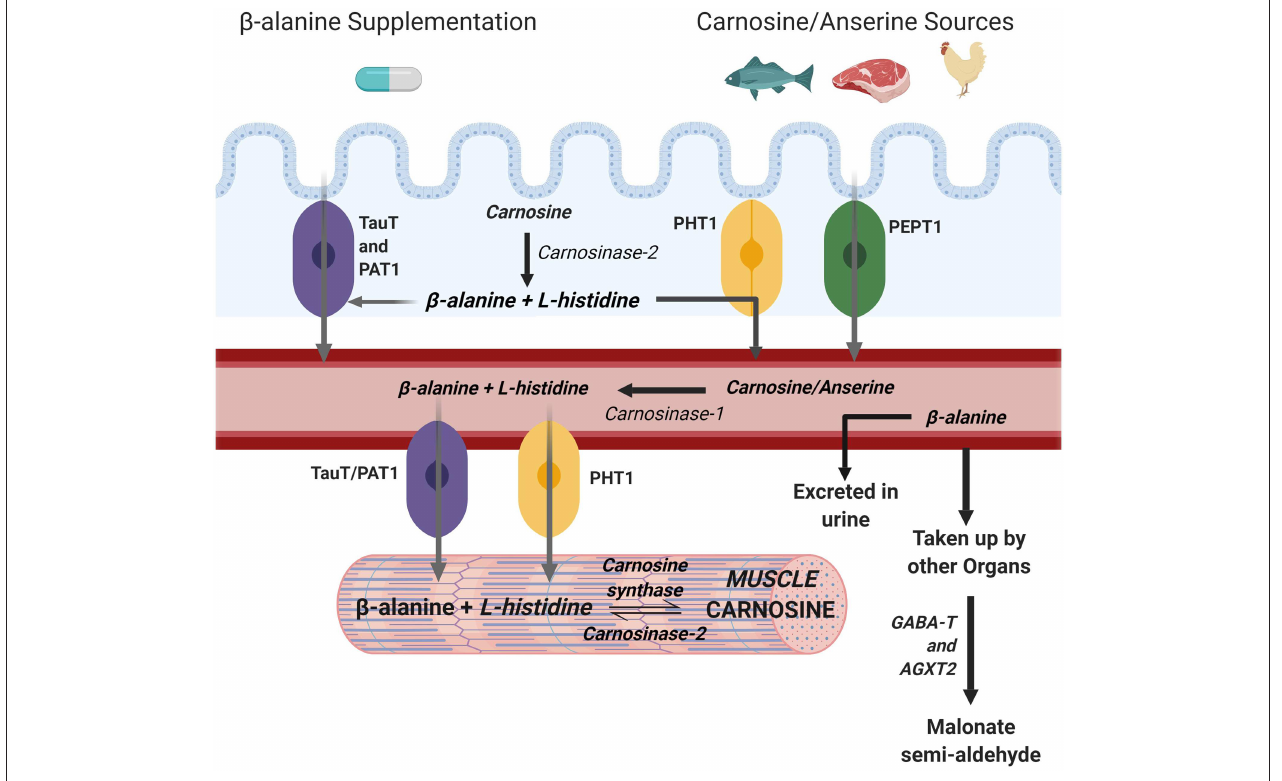
FIGURE 1 | Metabolism of muscle carnosine. Created with